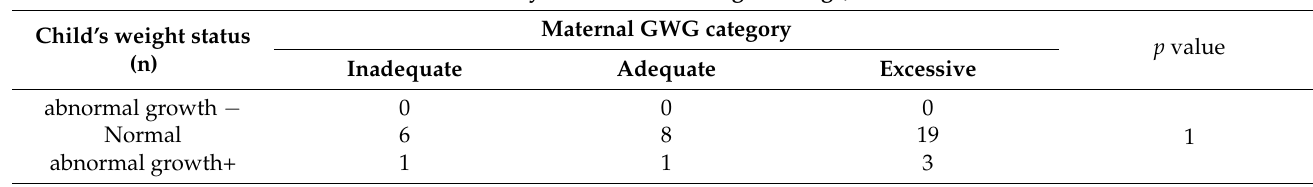
Classification by centile charts: weight-for-age, 24 months